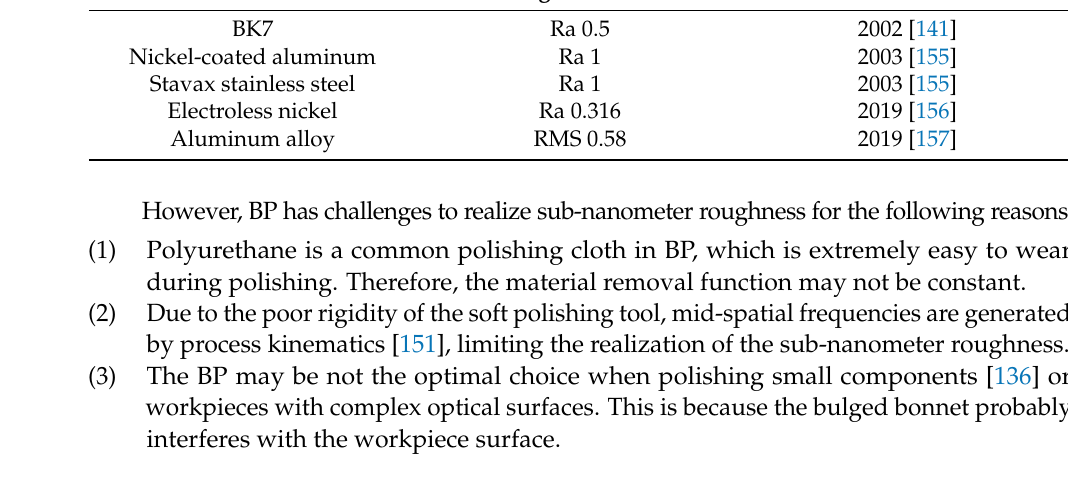
Table 6. The ultimate roughness achieved with BP for different materials. Material Roughness (nm) BK7 Nickel-coated aluminum Electroless nickel Aluminum alloy RMS